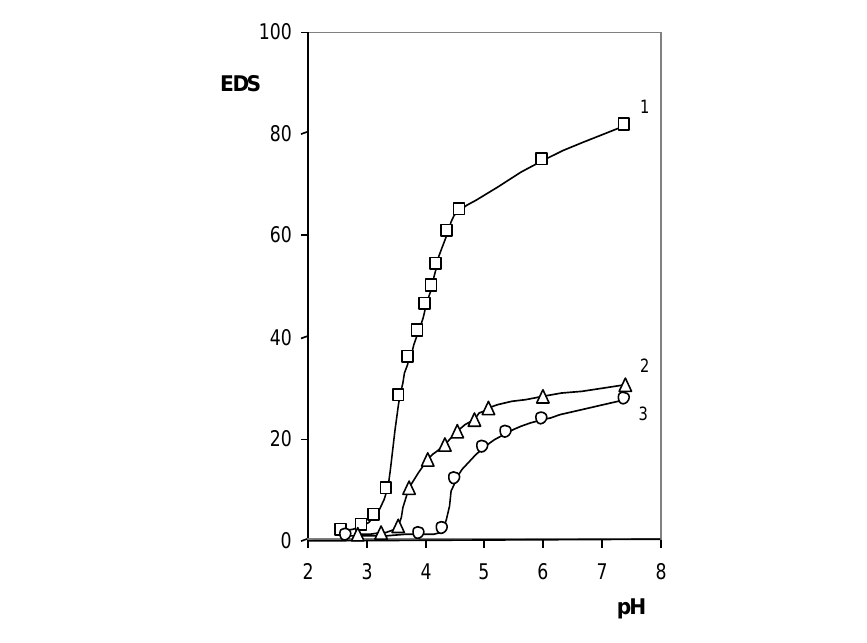
Figure 5. Equilibrium degree of swelling (EDS) in relation to pH for the hydrogels NIP-AVa-PEG575 (1); NIP-AVa-PEG258 (2); and NIP-PHE-PEG258 (3) at 25 °C in 0.15M